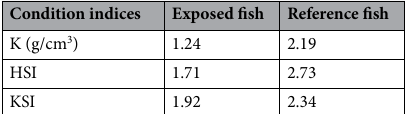
Table 4. Condition indices of fish Bagarius bagarius